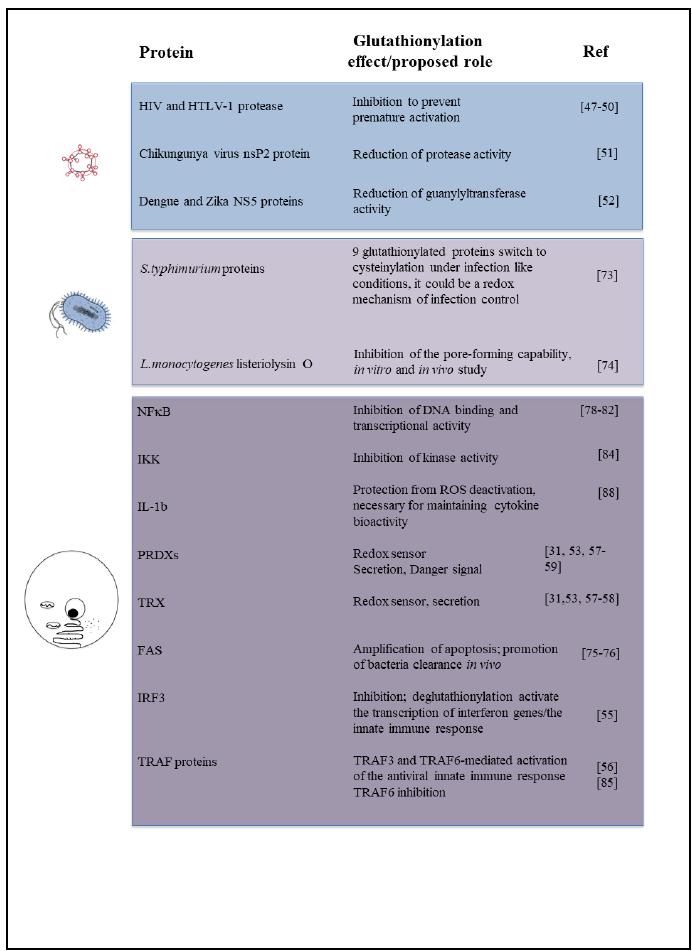
Figure 2. Diagram summarizing the effect or biological role, known or proposed, of glutathionylation on proteins described in this review, including the relevant references.